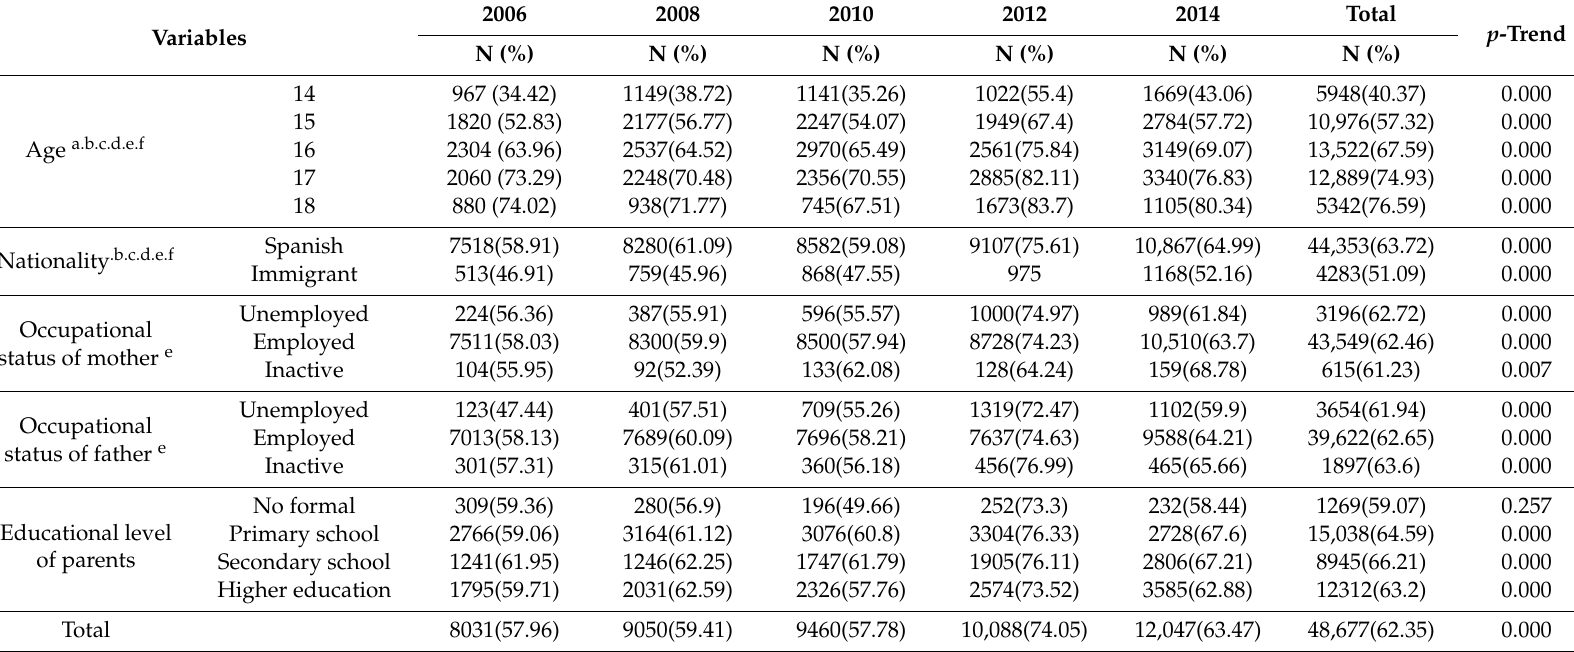
Table 1. Prevalence of alcohol consumption among Spanish female adolescents aged 14 to 18 years in Spain, according to sociodemographic variables. ESTUDES surveys